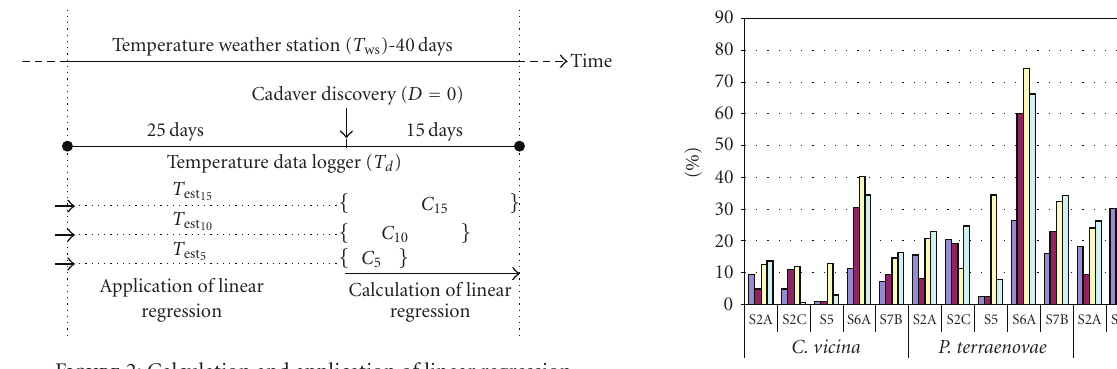
Figure 2: Calculation and application of linear regression. Table 2: Thermal parameters ( ◦ C) regulating development of flies. Figure 3: Di ff erences between ADD T d and ADD values using T ws Data are from Marchenko [19] (ADD: accumulated degree day). and correlations compared to ADD T d , expressed as percentages ([ADDx-ADD T d )/ADD T d ] × 100) for data registered in spring. ADD from egg to Species adult